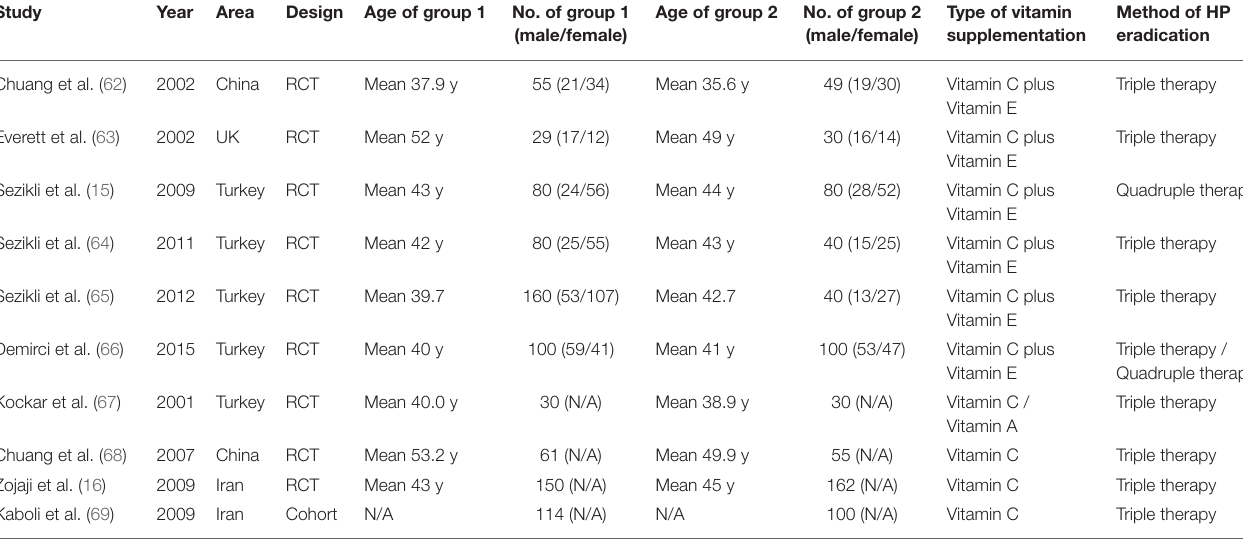
Group 1: antibiotic + vitamin groups. Group 2: antibiotic